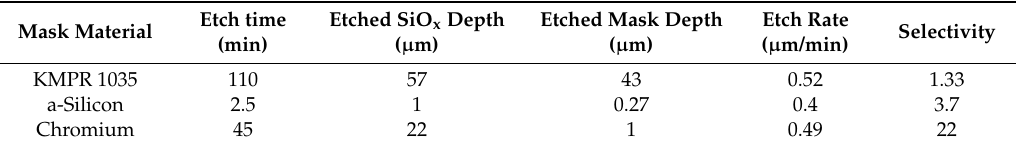
Table 1. Fused silica etch rate and selectivity.